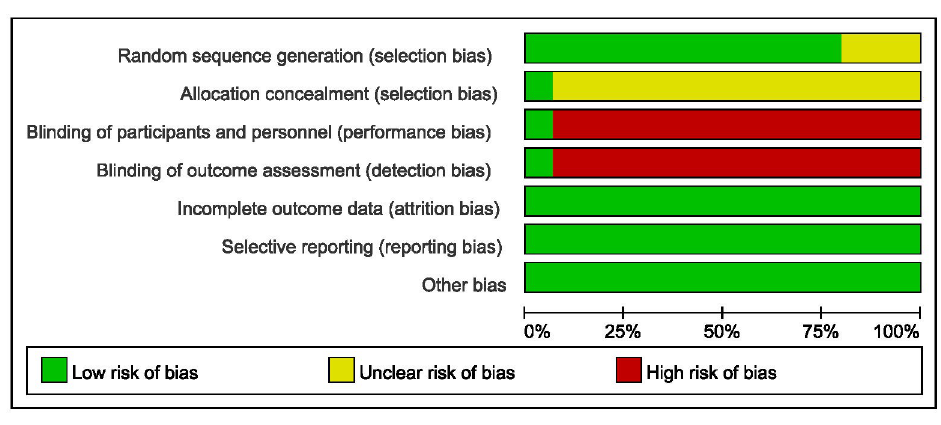
Fig 2. Risk of bias